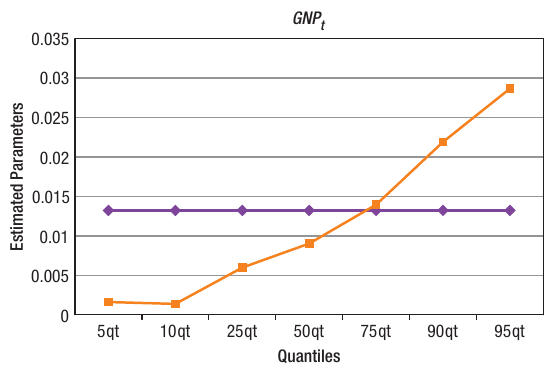
Fig. 7. Estimated parameters of relationship between I Notes: 1. The linear relationship represents OLS regression. 2. The non-linear relationship represents quantile